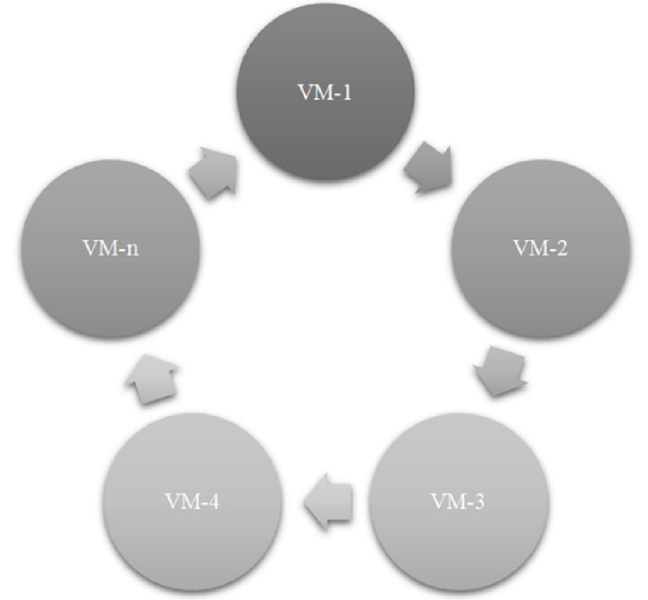
Figure 1. The relationship between virtual machines in the RR algorithm [1].